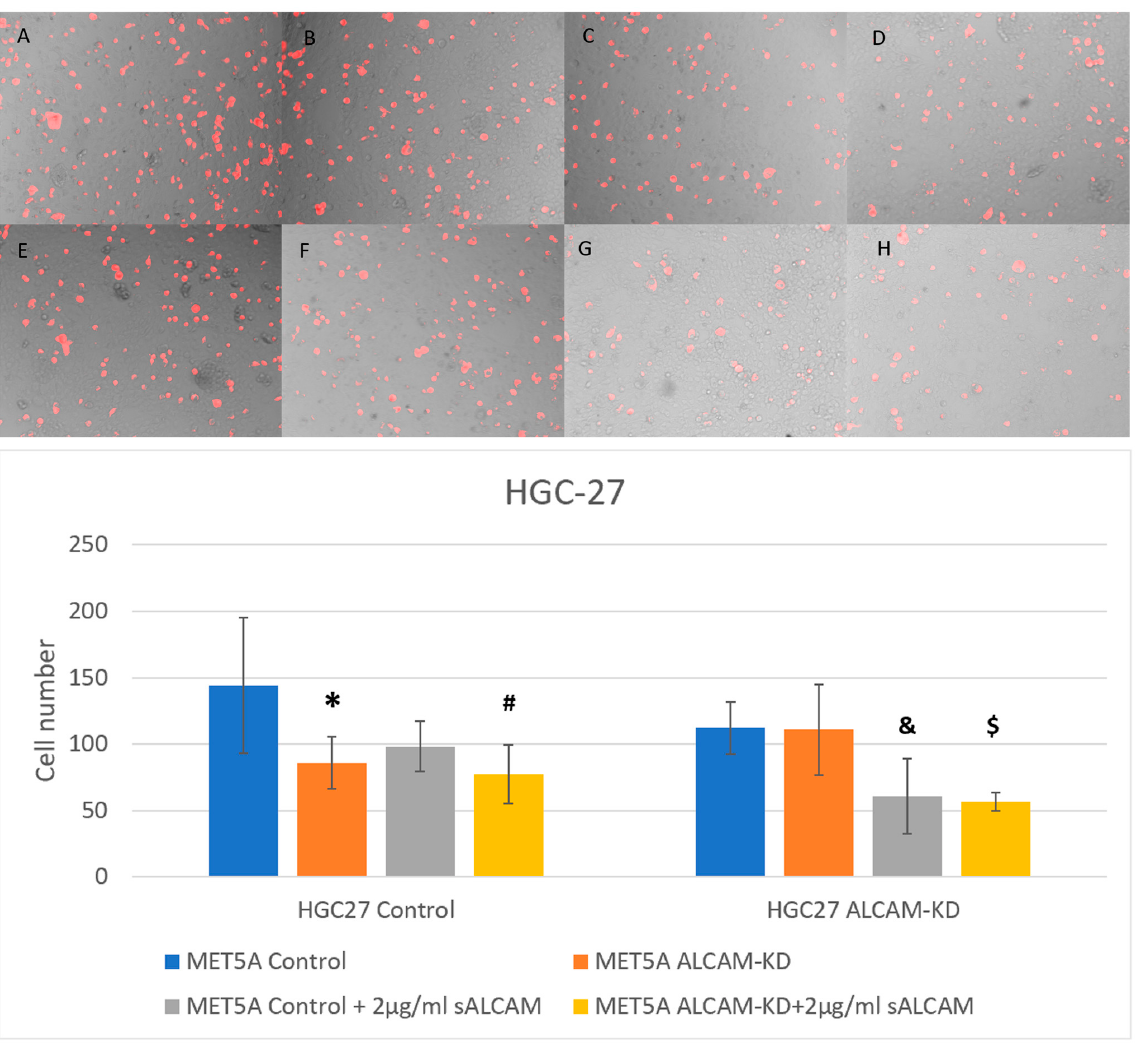
Figure 9. Interaction between gastric cancer cell line HGC-27 and mesothelial cell line MET5A as determined by the DiI based assays. ( Top ): Representative images (×10 magnification) of gastric cancer cells (HGC-27 Control and ALCAM knockdown cells) adherence to mesothelial cells (MET5A Control and ALCAM knockdown cells). ( A – D ) represent wells without any treatment and E-H represent wells treated with 2 µg/mL sALCAM. ( A , E ): MET5A Control + HGC27 Control; ( B , F ): MET5A Control + HGC27 ALCAM knockdown; ( C , G ): MET5A ALCAM knockdown + HGC27 Control; ( D , H ): MET5A ALCAM knockdown + HGC27 ALCAM knockdown. ( Bottom ): Graphical representation of gastric cancer cells (HGC-27 Control and ALCAM knockdown cells) adherence to mesothelial cells (MET5A Control and ALCAM knockdown cells). *: Groups which showed significantly differences compared with “MET5A Control + HGC27 Control” group ( p < 0.05). #: Groups which showed significantly differences compared with “MET5A Control + HGC27 Control + sALCAM” group ( p < 0.05); &: Groups which showed significantly differences compared with” MET5A Control+ HGC27 ALCAM-KD” group ( p < 0.05); $: Groups which showed significantly differences compared with “MET5A ALCAM-KD + HGC27 ALCAM-KD” group ( p < 0.05).